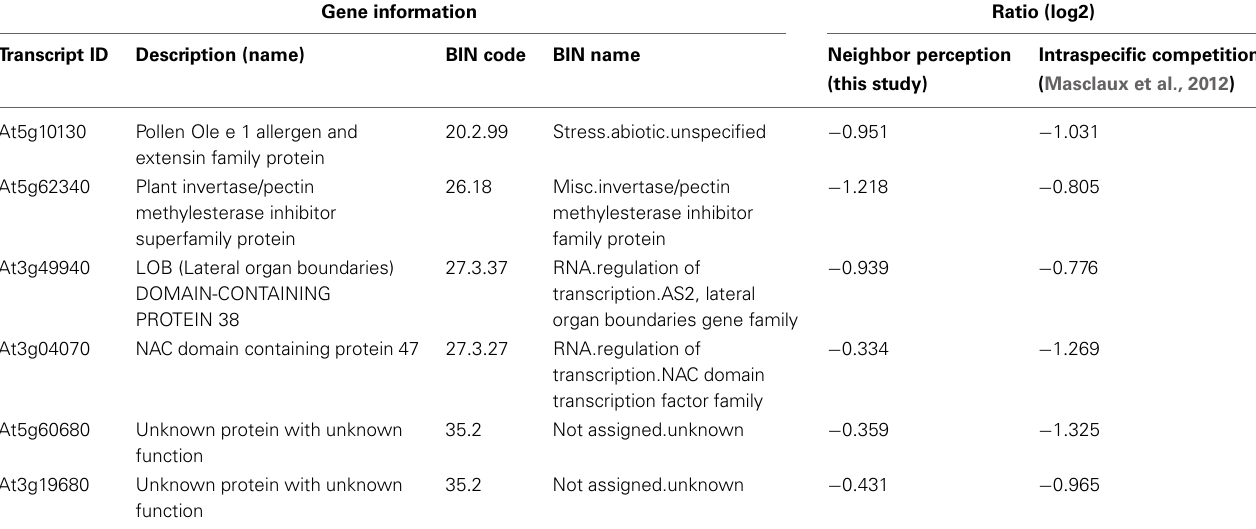
Table 4 | List of repressed transcripts regulated in concordance with transcriptional responses to intraspecific competition as examined by Masclaux et al.